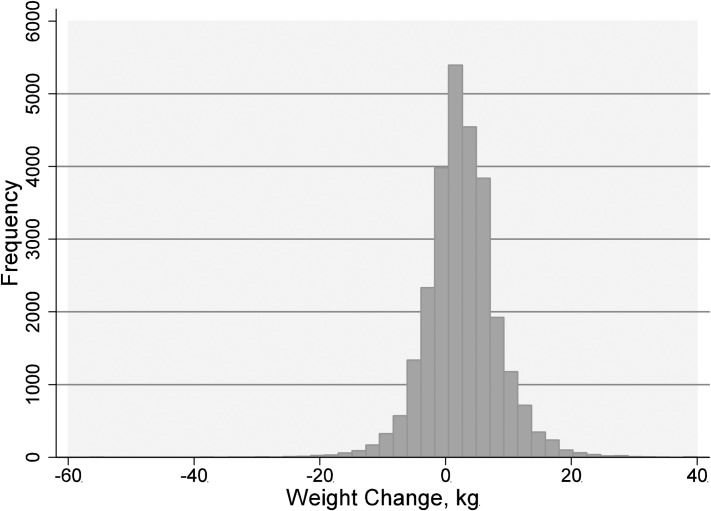
Distribution of weight change (in kgs) in the study population